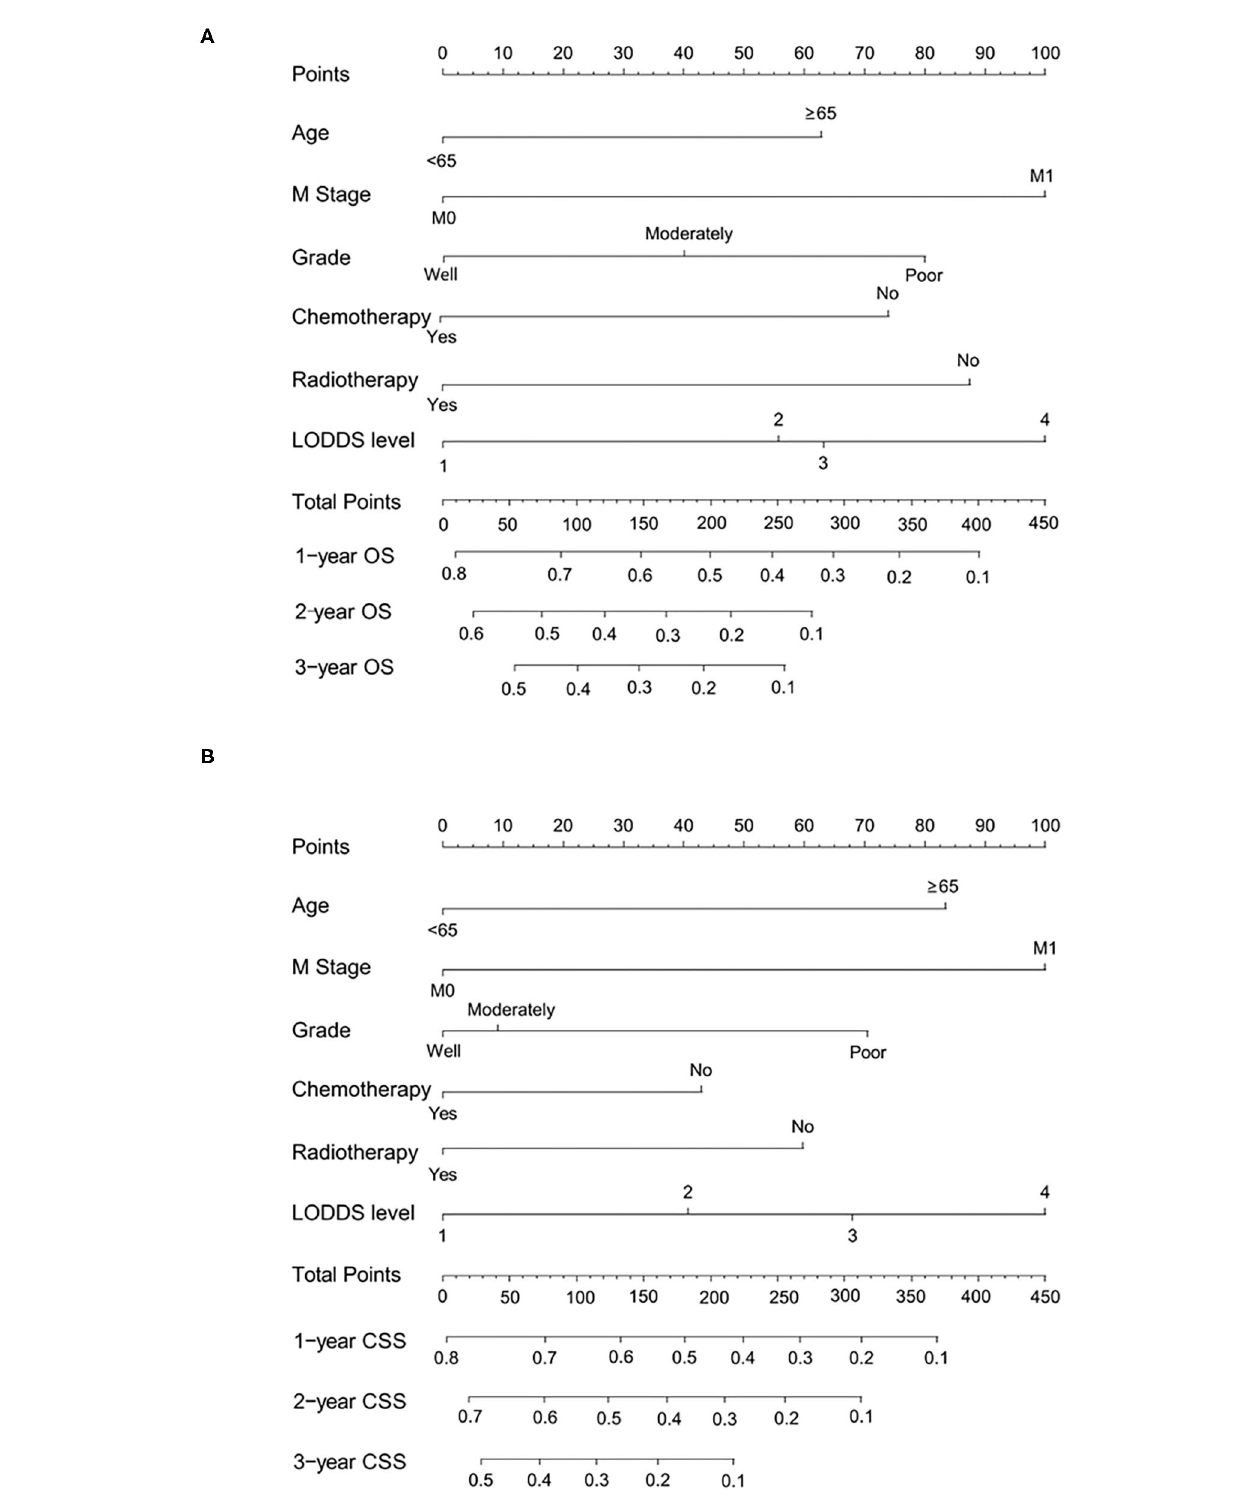
FIGURE 3 | Nomograms predicting 1-, 2-, and 3-year OS (A) and CSS (B) of patients with advanced gallbladder cancer after resection. OS, overall survival; CSS, cancer-specific survival; LODDS, log odds of positive lymph nodes.